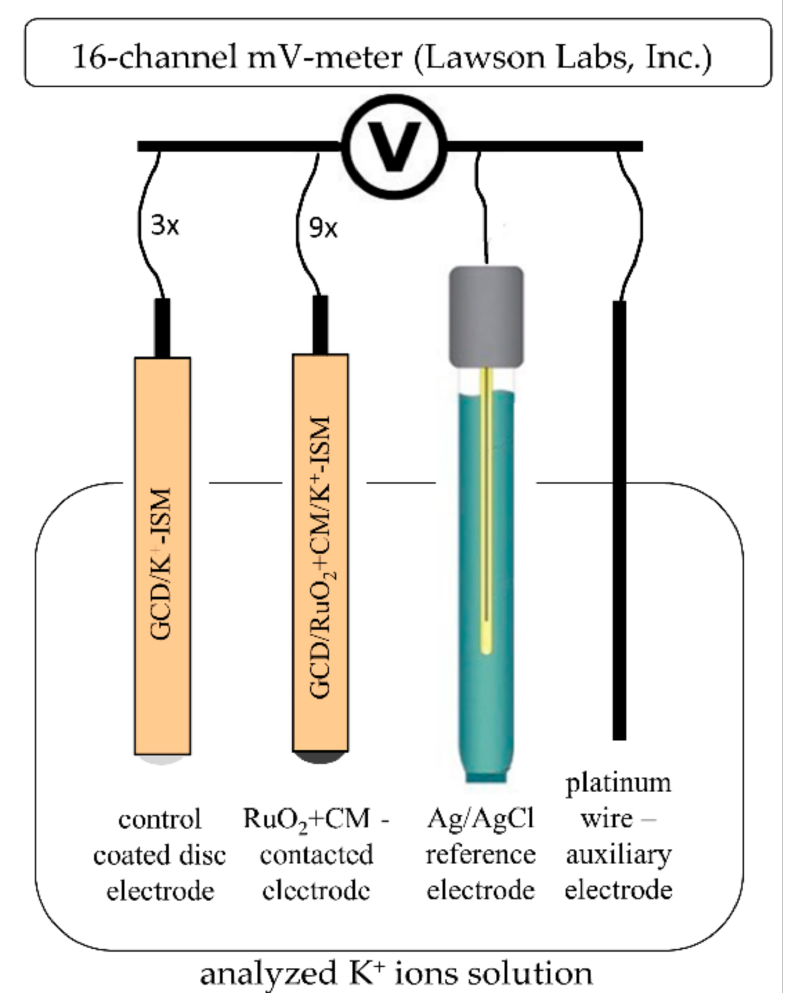
Figure 1. Experimental set-up for potentiometric